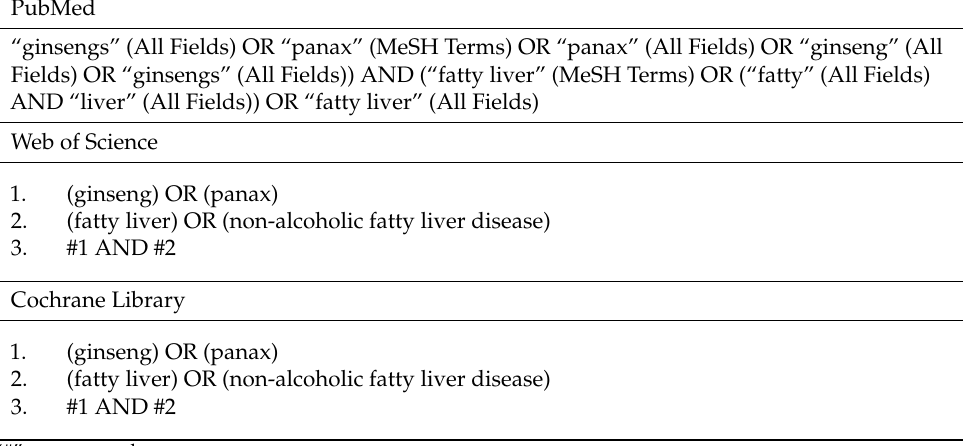
Table 1. Literature searching